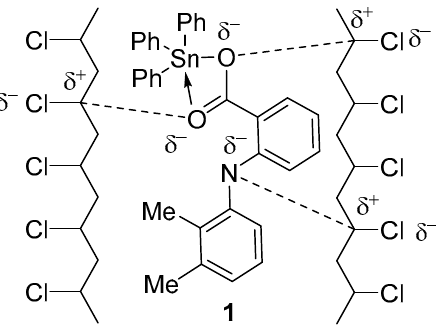
Figure 9. Attraction between organotin 1 and PVC chains.